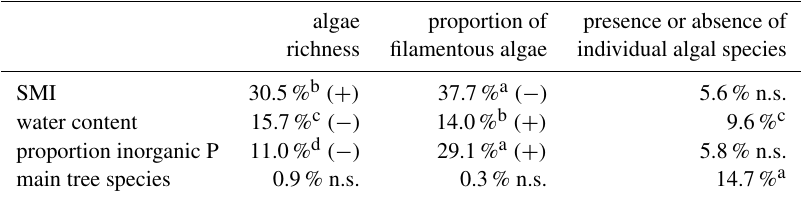
Table 3. Effect of environmental factors on algae richness, filamentous algae proportion (both estimated by ANOVA) and presence or absence of individual algal species (estimated by PerMANOVA) quantified by the percentage of explained variance. The significance level is indicated by a – p < 0 . 001, b – p < 0 . 01, c – p < 0 . 05, and d – p − < 0 . 1. ns–not significant; ( + ) indicates positive correlation, ( − ) negative